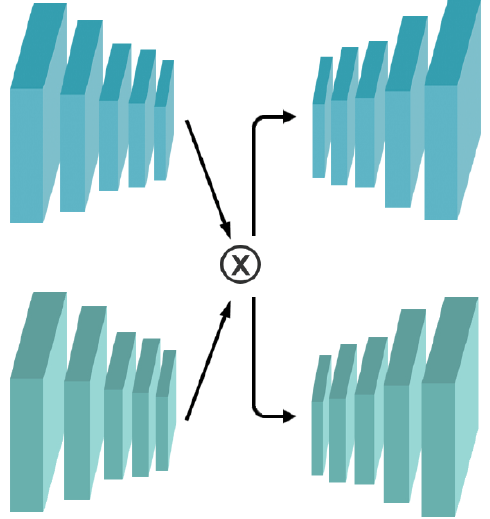
Figure 2. Inference and recognition networks in EVAE. In this figure, we outline usage inference and recognition networks (deep neural networks for encoders and decoders in our proposed EVAE) to wrap the model and variational parameters of the joint encoder and decoder in the EVAE. The upper panel (cyan-coloured) shows incorporated inference and recognition networks for our base VAE, whereas networks in the lower panel (green-coloured) were employed for the scaffolding VAE. Note here that x (cid:13) indicates the imposed learning